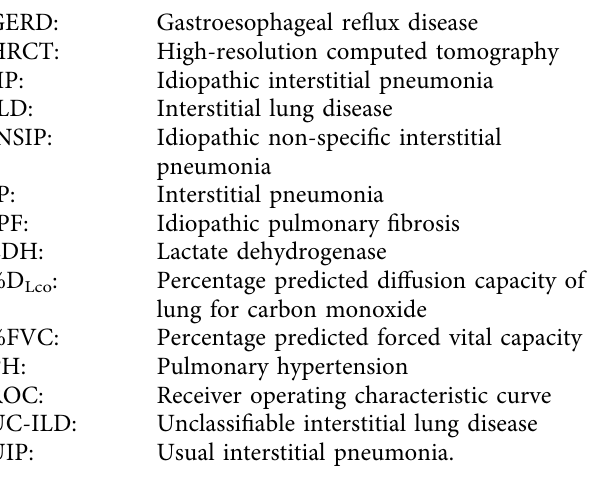
Supplement Figure 1: Te ILD-GAPC score according to ILD-related events or nonrespiratory mortality. Figure legends: the ILD-GAPC score with ILD-related events was signifcantly higher than those without (3.6 ± 1.5 points ( P < 0 . 001) (A)). Tere was no signifcant diference in the ILD-GAPC score between with nonrespiratory mortality and without (3.0 ± 1.2 points vs. 2.2 ± 1.7 points ( P � 0 . 098) (B)). Abbreviations: ILD, interstitial lung disease; GAPC, gender/age/physiology/Charlson Comorbidity Index score. Supplement Figure 2: Kaplan − Meier curves only in the % FVC > 75% (%FVC score: 0 points) populations. Figure legends: in the %FVC > 75% (%FVC score: 0 points) pop- ulations, ILD-GAPC better predicted the 3-year ILD-related events than ILD-GAP. Abbreviations: ILD, interstitial lung disease; G/A/P, gender/age/physiology; GAPC, gender/age/ physiology/Charlson Comorbidity Index score. Supplement Figure 3: Te Kaplan − Meier curves among patients with treatment interventions ( n = 49). Figure legends: None of the Kaplan − Meier curves for predicting 3-year ILD-related events ((A) ILD-GAP model, (B) ILD-GAPC model) or 3-year all-cause mortality ((C) ILD-GAP model, and (D) ILD-GAPC model) showed signifcant diferences. Abbre- viations: ILD, interstitial lung disease; G/A/P, gender/age/ physiology; Comorbidity Index score. Supplement Table 1: Relationships between ILD-GAP and ILD-GAPC. Footnote: Te re- lationship between ILD-GAP and ILD-GAPC ( R = 0.900 ( P < 0 . 001)). Abbreviations: GAP, gender/age/physiology; GAPC, gender/age/physiology/Charlson Comorbidity Index score; ILD, interstitial lung disease. (